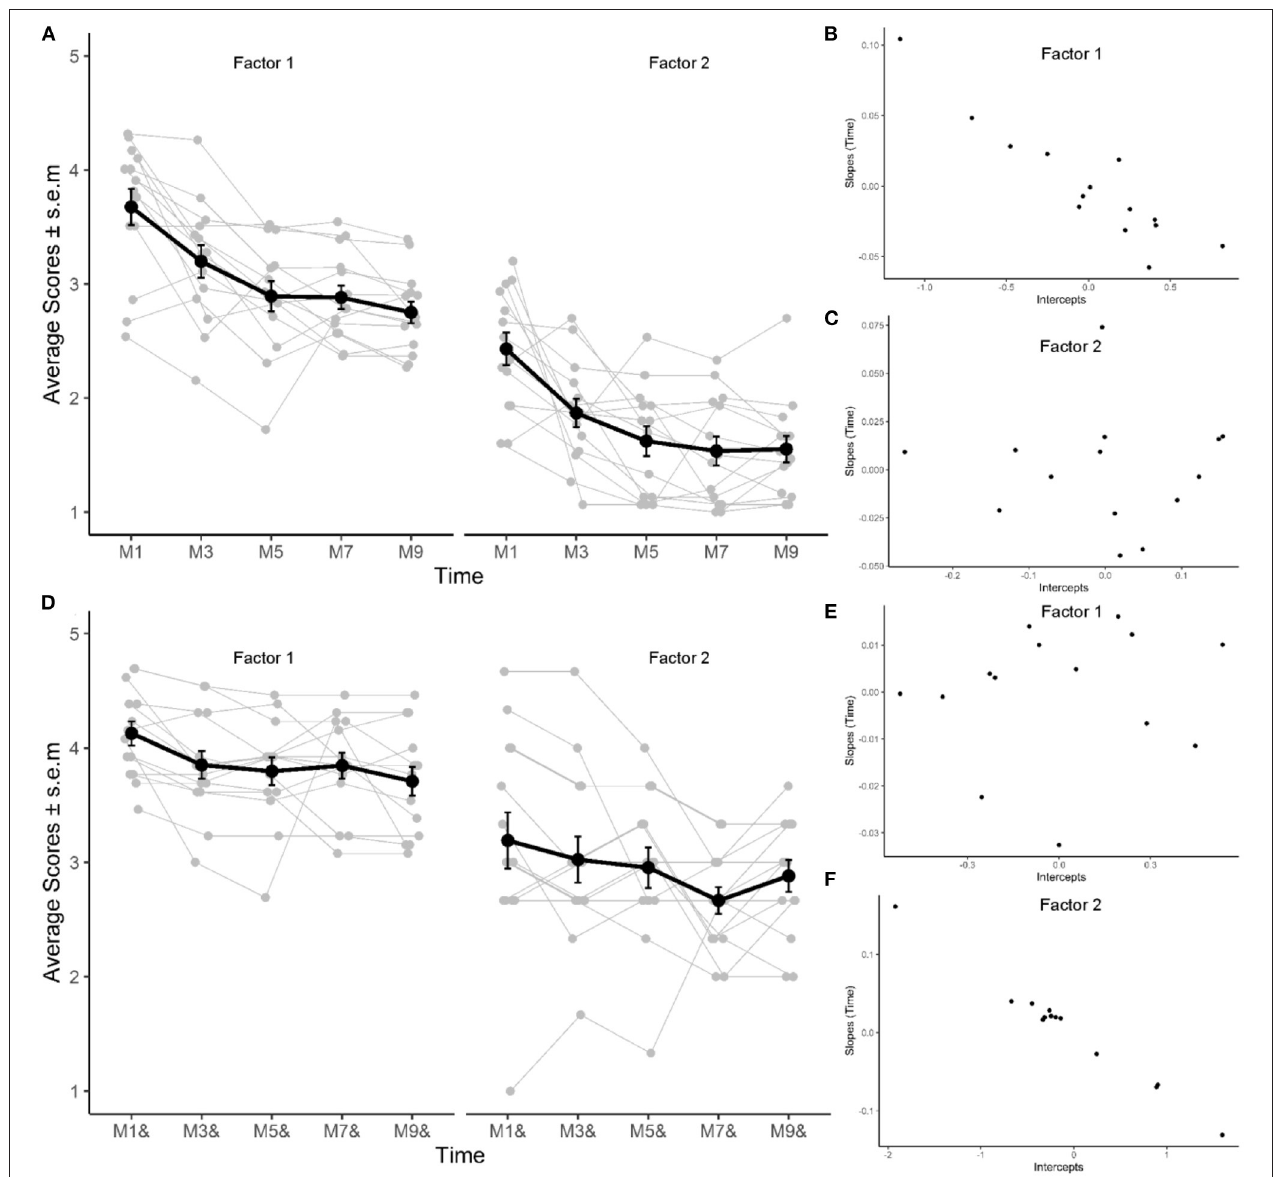
FIGURE 3 | Evolution of factors 1 and 2 of BSE-R during therapy. (A–C) Evaluation performed after one-to-one exchanges. (D–F) Evaluation performed in group therapy. (A,D) Average (black) and individual (gray; N = 14) scores assessed at months 1, 3, 5, 7, and 9 of therapy. (B,E) Correlation of within-subjects random intercept and slopes for factor 1 in individual and group therapy session, respectively. (C,F) Correlation of within-subjects random intercept and slopes for factor 2 in individual and group therapy session, respectively.